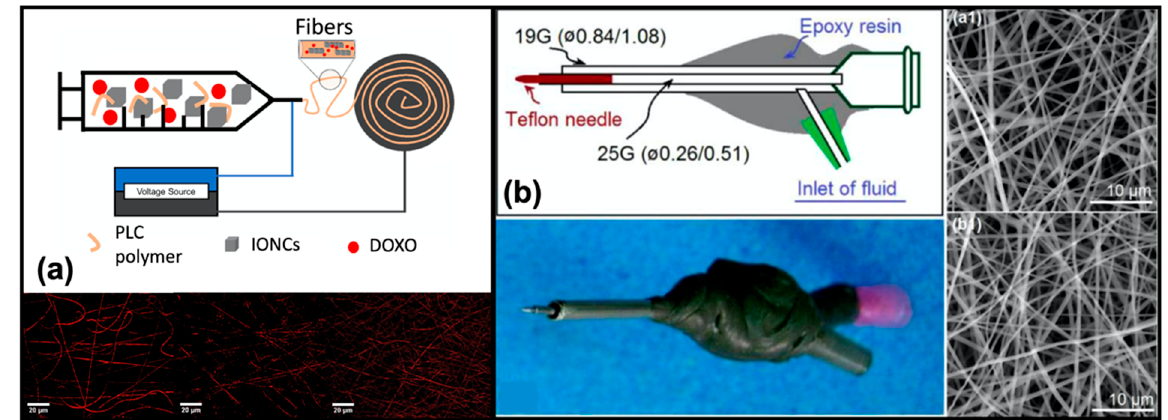
Figure 7. ( a ) Schematic representation of the system employed for fabrication of the magnetic fibers loaded with iron oxide nanocubes (IONCs) and DOXO, and confocal images of nanofibers with (15–23 nm) and without nanoparticles. Reprinted from [137] with permission under Journal of colloid and interface science license. ( b ) Schematic representation of the new proposed spinneret, with its digital photograph and SEM images of the obtained nanofibers from ( a1 ) the traditional process (N1), and ( b1 ) new ones (N2). Reprinted from [138].